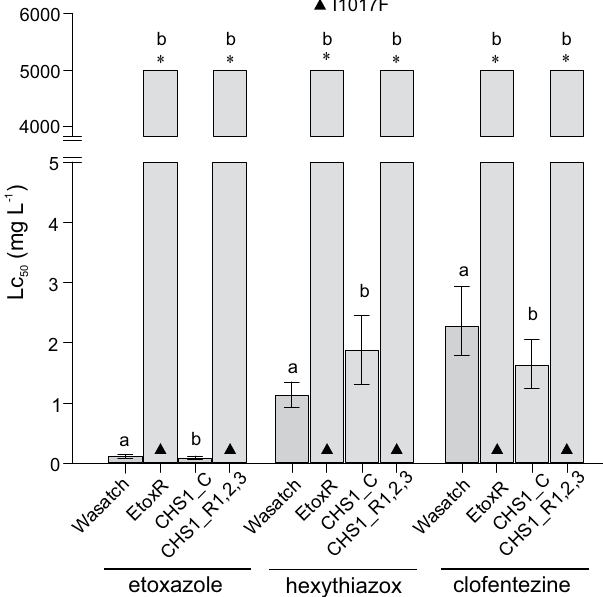
Figure 3. Susceptibility of backcrossed T. urticae lines CHS1_R1-R3 (I1017F) and CHS1_C and their susceptible and resistant parental strains, to mite growth inhibitors etoxazole (most left), hexythiazox (middle) and clofentezine (most right). Bars represent the acaricide concentration at which 50% of the individuals are affected. Error bars represent the 95% confidence limit calculated by probit analysis. As LC 50 values exceeded 5,000 mg l − 1 for all CHS1_R1, R2 and R3 for each mite growth inhibitor tested, only one bar depicts LC 50 s. Stars indicate lines for which, LC 50 value exceeded 5,000 mg l − 1 . Letters above bars indicate lines where acaricide treatment had statistically the same ( a ) or different ( b ) effect comparing to Wasatch (PoloPlus LeOra Software) 49 .